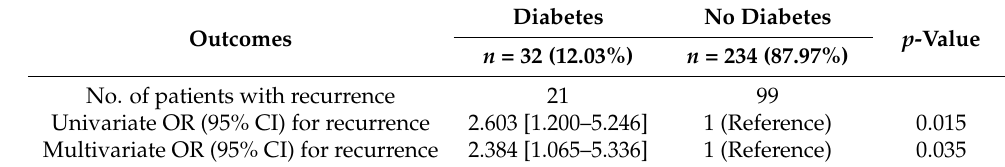
Figure 1. Comparing the survival curves for OS and RFS between the diabetes group and the no diabetes group of AC patients.